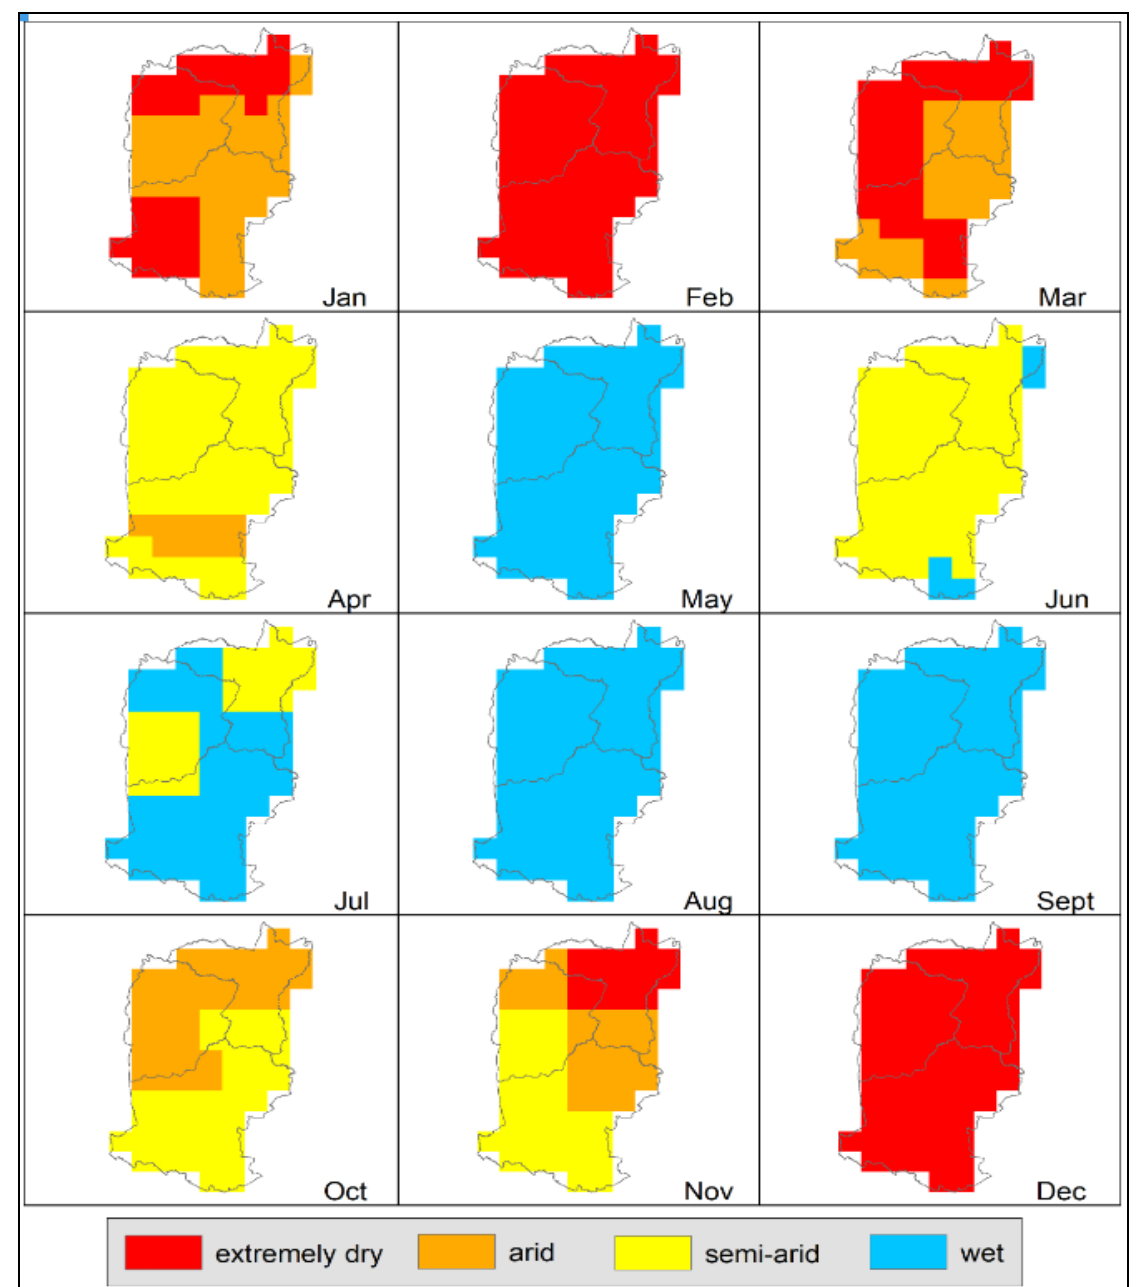
Figure 8. Thornthwaite aridity index map for 2012.